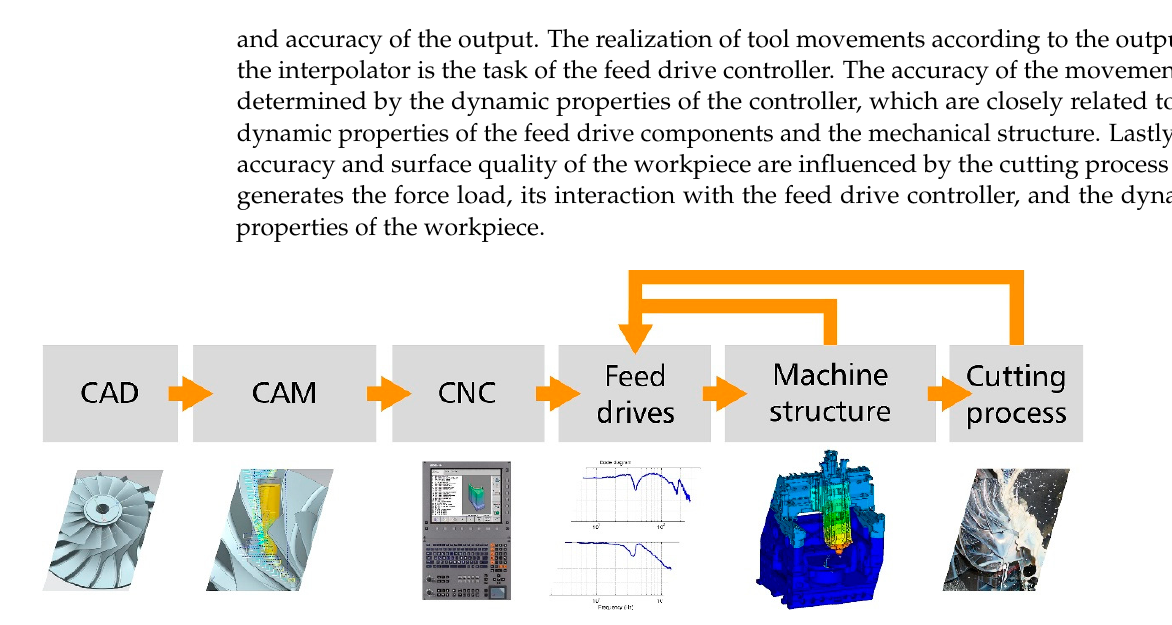
Figure 1. The chain of steps from the workpiece CAD model to the finished product. Each step has the potential to add additional inaccuracies that influence the quality of the final product.